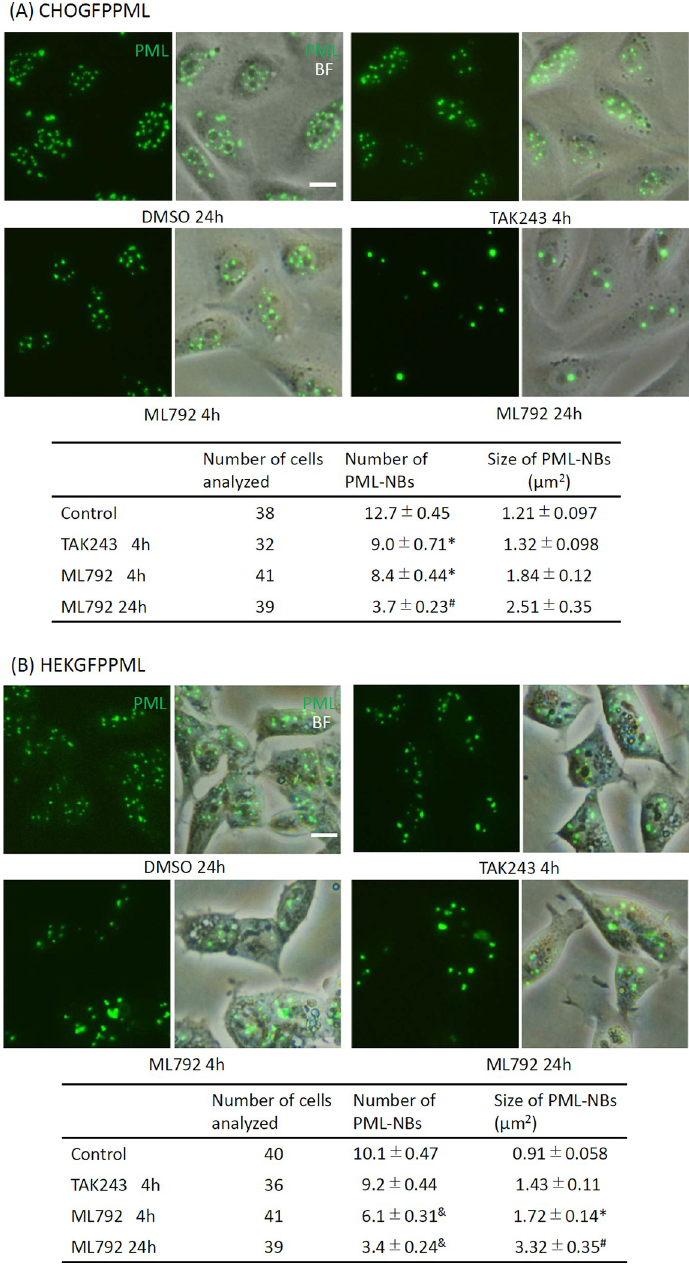
Fig 8. Effects of TAK243 (ubiquitination inhibitor) and ML792 (SUMOylation inhibitor) on the number and size of PML–NBs in CHOGFPPML (A) and HEKGFPPML cells (B). The cells were cultured in the presence of 0.1% DMSO (control), 10 μ M TAK243 for 4 h, or 20 μ M ML792 for 4 and 24 h. The number of PML–NBs in both cell types decreased and their sizes increased significantly by treatment with ML792. TAK243 was less effective than ML792 in decreasing the number of PML–NBs, and the cells looked shrunken and slightly damaged after 6 h of culture with 10 μ M TAK243. Data are presented as the mean ± SEM. � , Significantly different from control group. #, Significantly different from all other groups. &, Significantly different from control and TAK243 groups. Scale bar = 10 μ m.